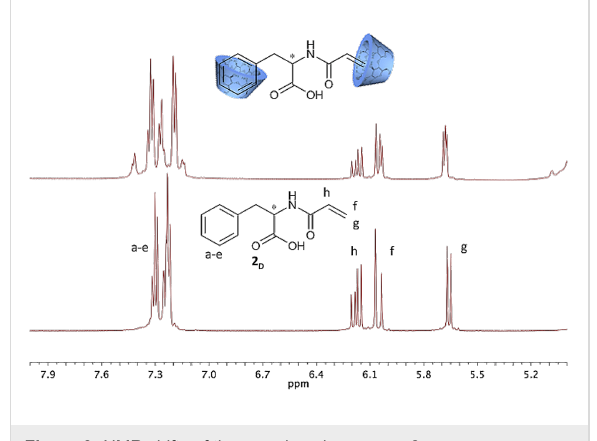
Figure 3: NMR shifts of the complexed monomer 2 D .